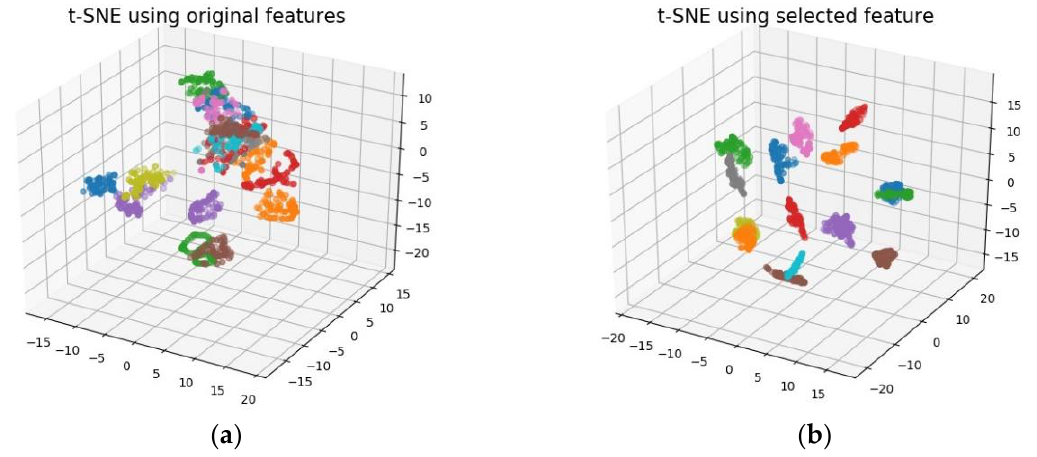
Figure 6. Correlation between features by MDV ( a ) and MDE ( b ).